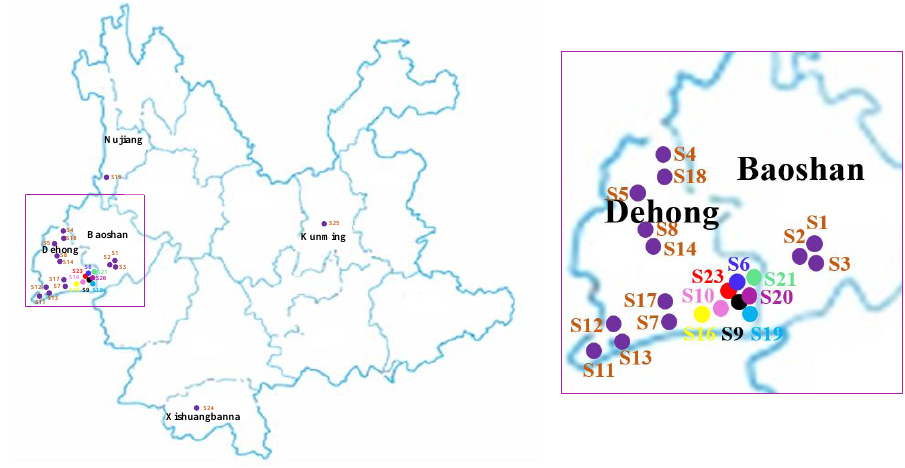
Figure 5. The sample collection areas of Moringa oleifera on the map.